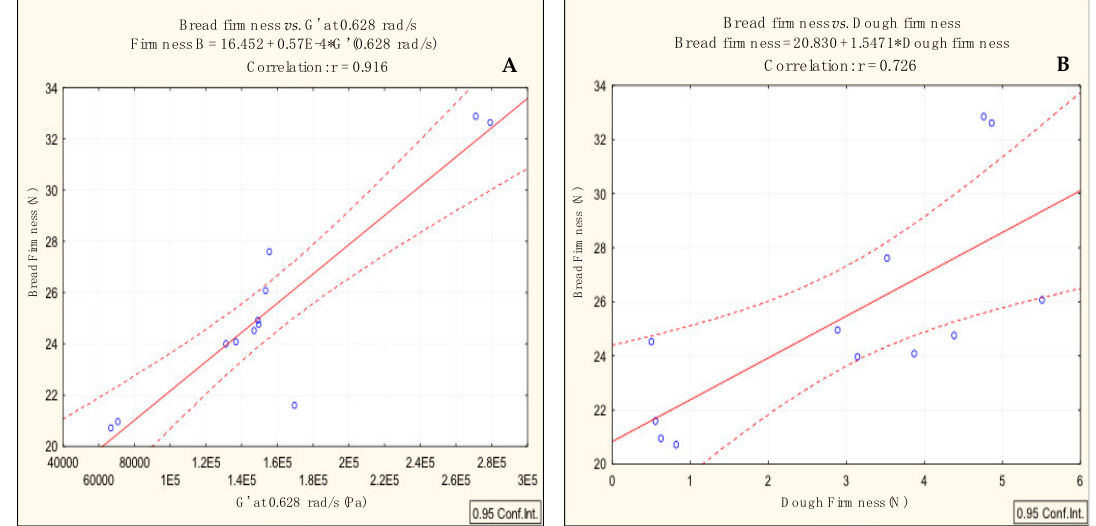
Figure 4. (A ): Correlation between bread firmness and the viscoelastic characteristics of the dough (G′ at 0.628 rad / s) and ( B ): correlation between the bread firmness and dough firmness.